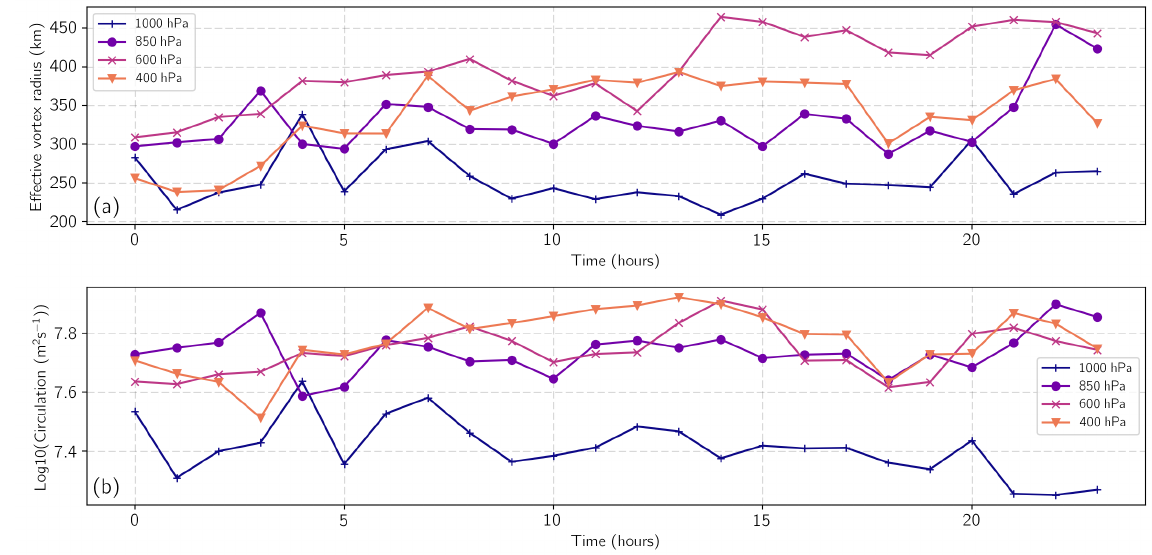
Figure 12. Temporal evolution of Kyrill’s vortex properties derived from CFSR data for 18 January 2007 (time in UTC) at different pressure levels inside a radius of 500km around circulation center of Kyrill at 850hPa: ( a ) effective radius (in km) and ( b ) logarithm of total circulation (in m 2 s − 1 ) derived by adding the positive circulations associated with Kyrill’s vortex